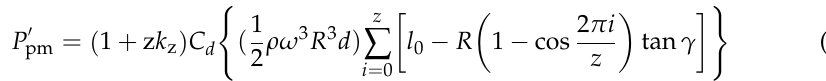
Figure 10. Residuals of different fitting curves: ( a ) exponential function fitting and ( b ) power function fitting.